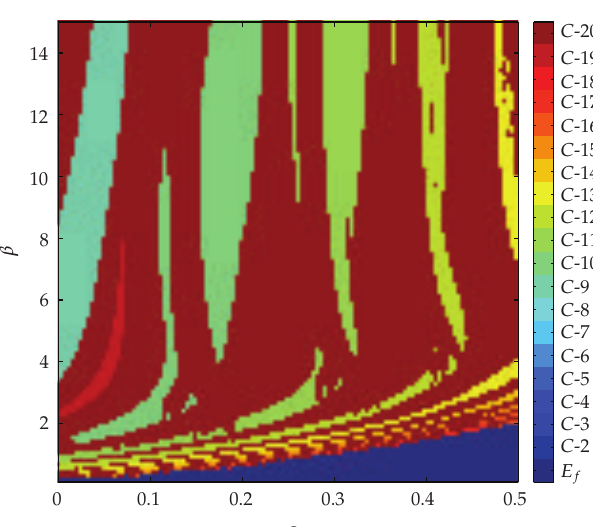
Figure 9: Two-dimensional bifurcation diagram in the parameter plane (cid:2) a,β (cid:3) for and i.c. x 0 (cid:9) 1 . 3, m 0 (cid:9) 1 w 0 (cid:9) − 1. The other parameter values as in Figure 5.